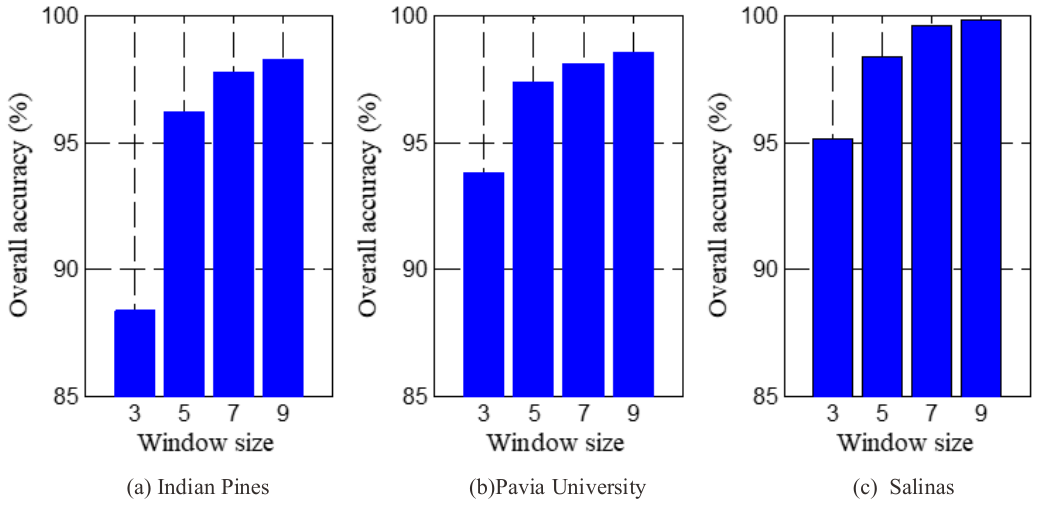
Figure 8. OA with SVM classifier versus the variation of window size.